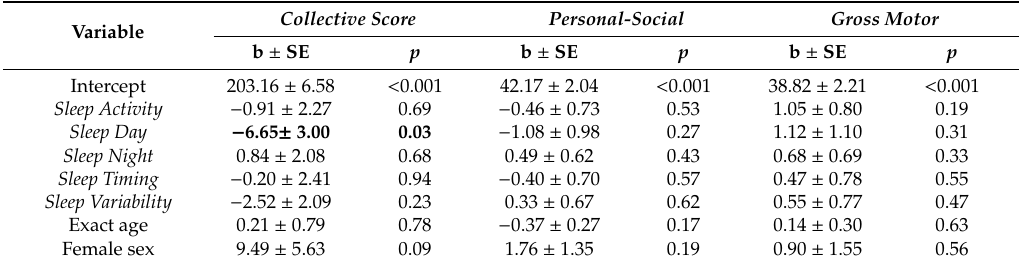
Figure 2. The percentile distribution is illustrated based on one randomly selected imputation (black; solid line = median, dashed line = interquartile range, dotted line = 90th percentile). A total of six randomly selected participants are represented, each with specific color. ( A ) shows Sleep Timing, the most stable composite. ( B ) shows Sleep O ff set, the highest loading single variable for Sleep Timing . ( C ) shows Sleep Activity , the least stable composite. ( D ) shows Longest Nocturnal Wake, the highest loading single variable for Sleep Activity. Results illustrate that the position of a participant within the percentile distribution fluctuates across the assessments of 3, 6, and 12 months. In other words, e.g., an infant with a comparatively high score on Sleep Activity at 3 months does not necessarily maintain a high score in Sleep Activity at 6 and 12 months. Table 4. Associations between sleep composites and behavioral development as quantified by the Ages and Stages questionnaire. Bold font indicates significant associations ( p < 0.05). SE = Standard error of